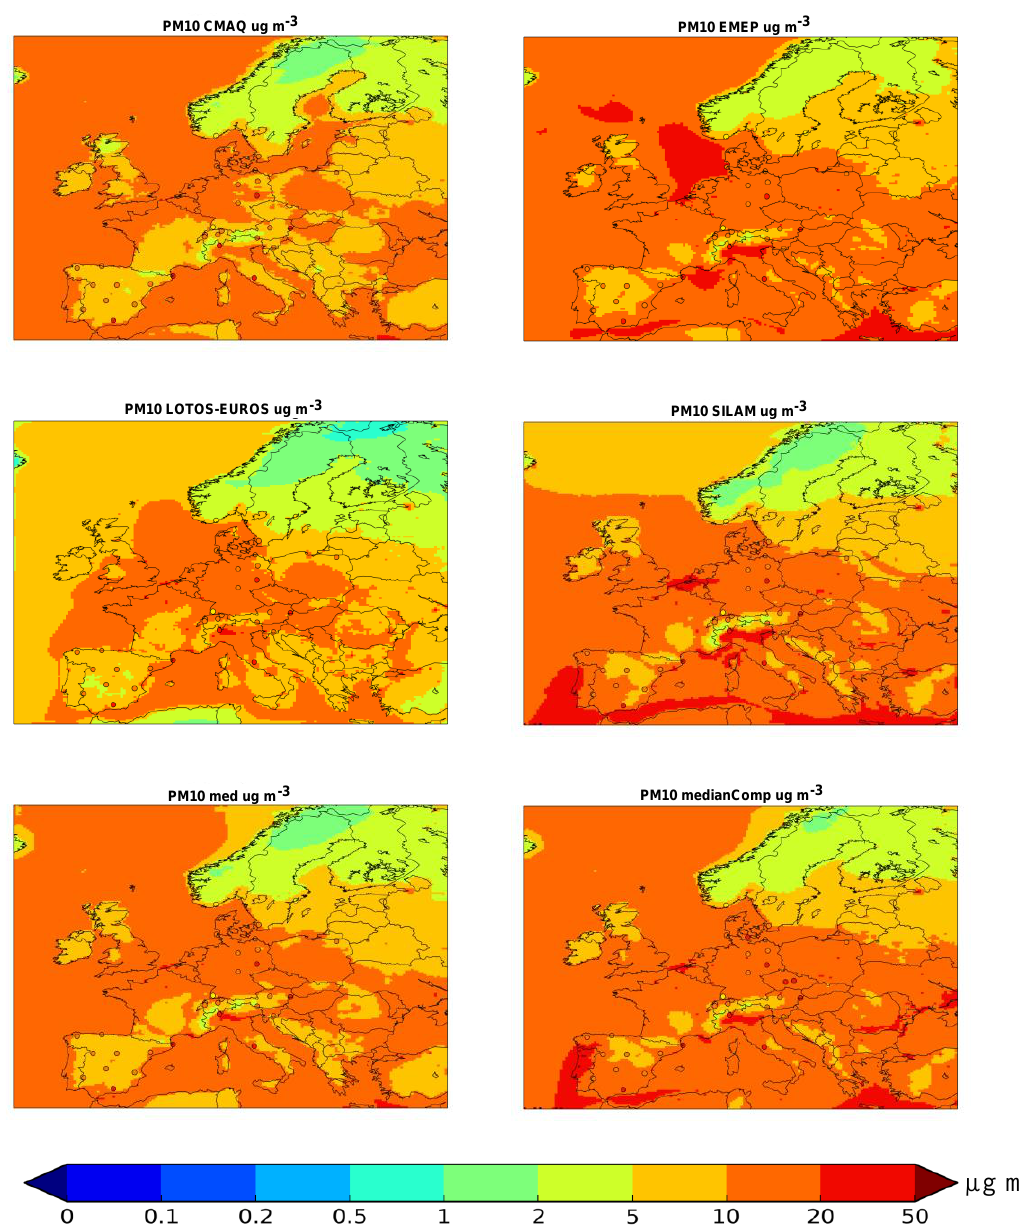
Figure 2. Annual mean dry PM 10 concentration predicted by the models, their median and medianComp (µgPMm − 3 ). The dots show the annual mean observed values in EMEP stations (only the stations with observations available for at least 75% of the time are